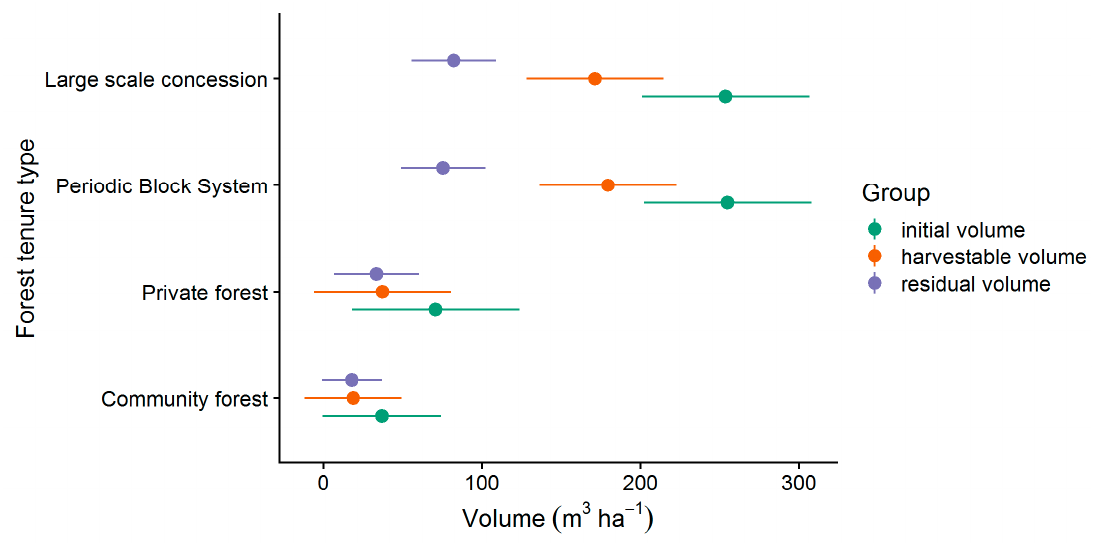
Figure 6. Mean commercial volumes (all CSC, LG 1 & 2) and 95%-confidence intervals.